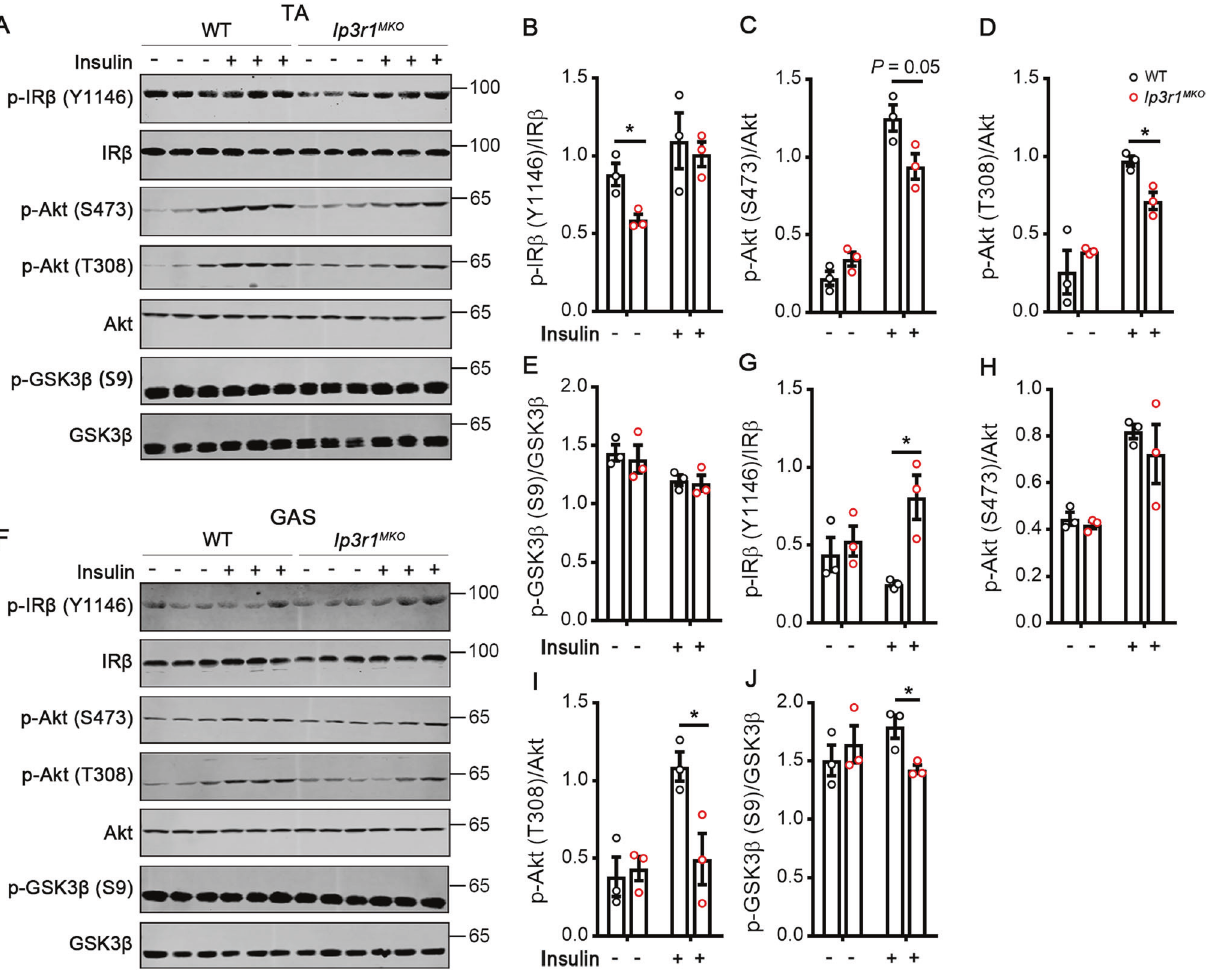
( A – E ) TA and ( F – J ) GAS lysates. Quanti fi cation of p-IR β (Y1146)/IR β , p-Akt (S473)/Akt, p-Akt (T308) /Akt, and p-GSK3 β (S9)/GSK3 β was determined by ImageJ software ( n = 3). All data were analyzed by two-tailed unpaired Student ’ s t test and presented as means ±